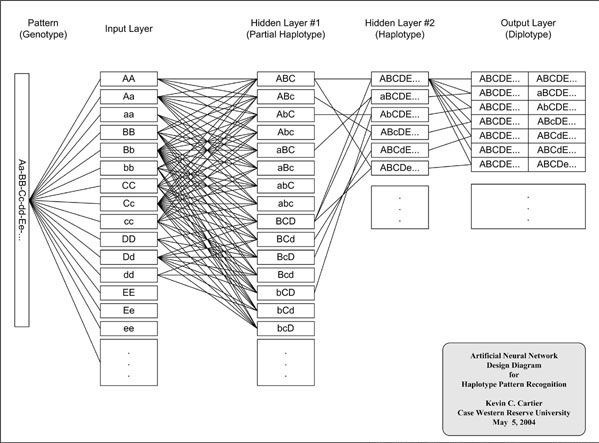
Artificial neural network design for haplotype pattern recognition.